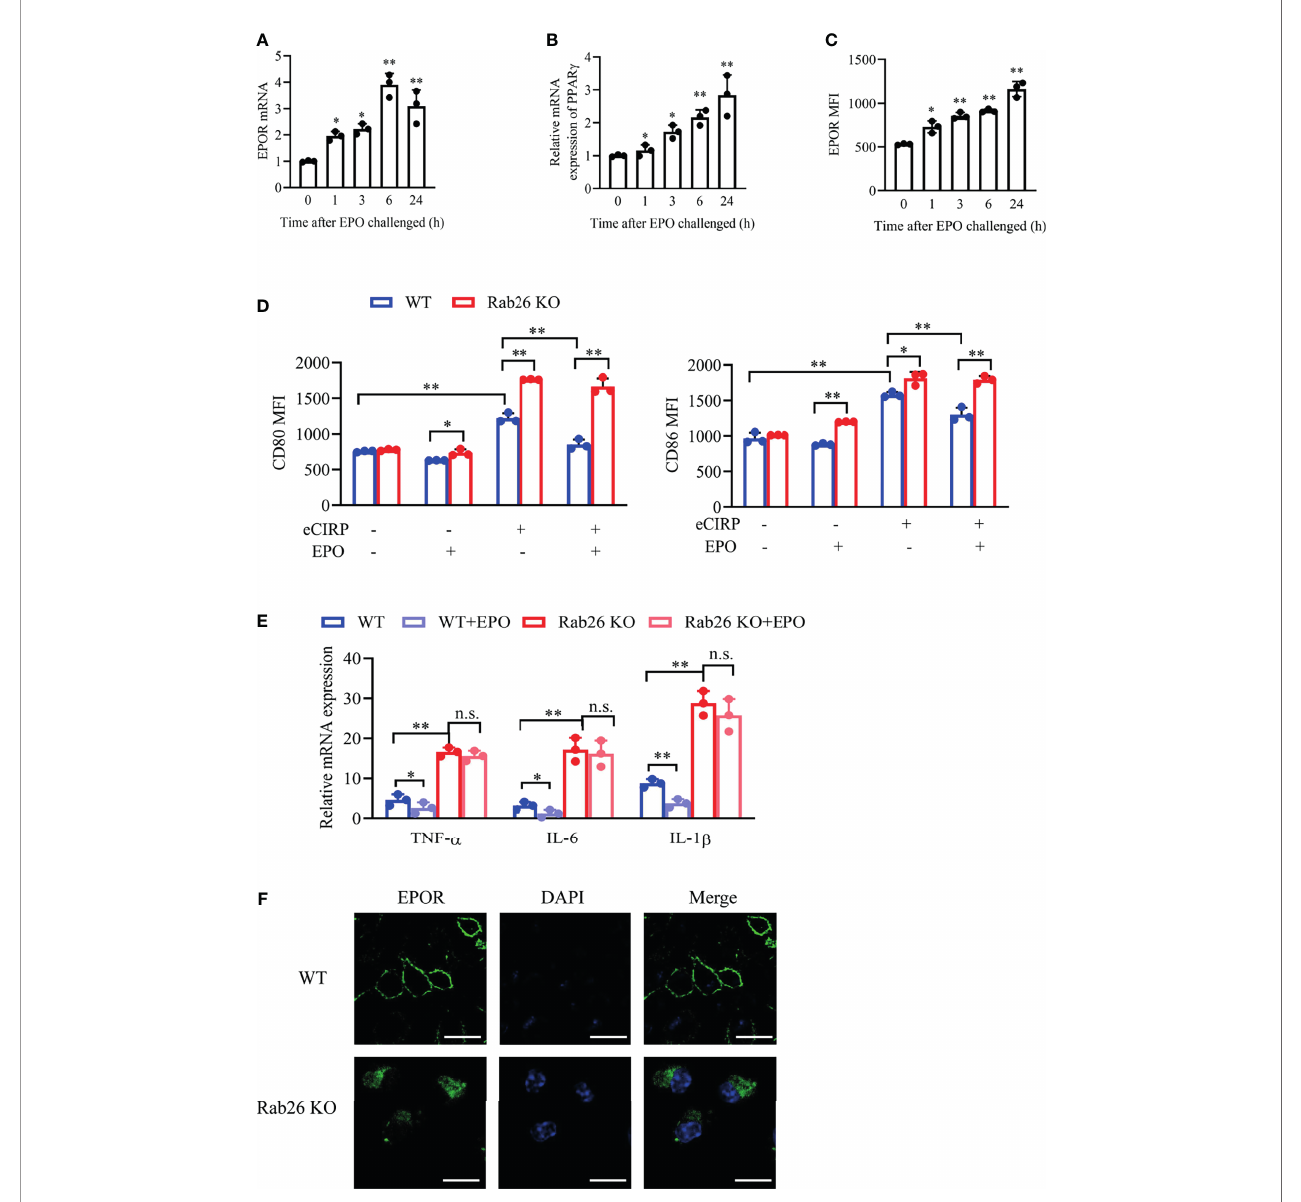
FIGURE 7 | Rab26 de fi ciency reduces EPOR signaling and restrains macrophage polarization. A qPCR assay was conducted to evaluate the mRNA expression of EPOR (A) and PPAR g (B) in WT BMDMs treated with rhEPO (20 IU/ml) for the indicated time (n = 3). (C) The MFIs of cell surface EPOR in BMDMs treated with rhEPO (20 IU/ml) for the indicated times were tested by FACS (n = 3). * P < 0.05, ** P < 0.01 vs. 0 h. (D) The MFIs of CD80 and CD86 were evaluated by FACS in WT and Rab26 -/- BMDMs treated with or without eCIRP (1 µg/ml) or rhEPO (20 IU/ml) for 24 h (n = 3). (E) A qPCR assay was conducted to evaluate the mRNA expression of TNF- a , IL-6, and IL-1 b in WT and Rab26 -/- BMDMs treated with eCIRP (1 µg/ml) and rhEPO (20 IU/ml) for 24 h (n = 3). (F) Localization of EPOR in WT and Rab26 -/- BMDMs. WT and Rab26 -/- BMDMs were stained with an anti-EPOR antibody (1:100 dilution) and Alexa Fluor 488-labeled secondary antibody (1:200 dilution) (green), and nuclei were stained with DAPI (blue). Representative confocal images of the surface and intracellular expression of EPOR are shown. Scale bar: 10 µm. Data are representative of at least two independent experiments. Results were expressed as mean ± SD. n. s., not statistically signi fi cant. * P < 0.05, ** P < 0.01. Statistics: One-way ANOVA with Tukey ’ s post-hoc test for multiple comparisons (A – E) . EPOR, erythropoietin receptor; PCR, polymerase chain reaction; PPAR, peroxisome proliferator-activated receptor; BMDM, bone marrow derived macrophage; EPO, erythropoietin; MFI, mean fl uorescence intensity; FACS, fl uorescence activated cell sorter; eCIRP, extracellular cold-inducible RNA-binding